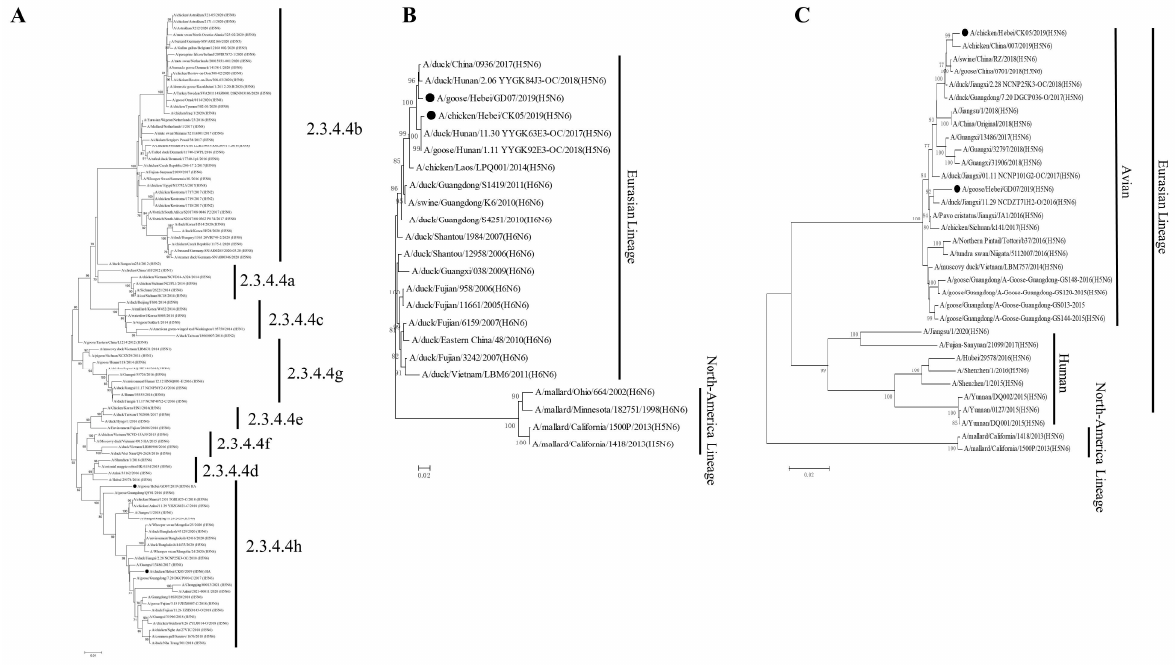
Figure 1. Phylogenetic trees of the HA, NA, and PB2 genes of the H5N6 (CK05 and GD07) viruses. ( A ) Phylogenetic tree of HA. ( B ) Phylogenetic trees of NA. ( C ) Phylogenetic trees of PB2. Sequences in this study are marked with black chicken or goose.